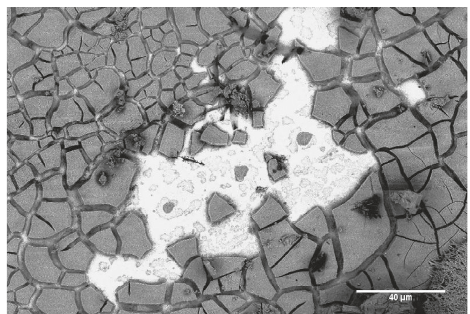
Figure 8: SEM image of a crack region on the surface of the sample synthesized at 120 ° C for 36h with NaOH concentration of 0.75M after heat treatment. Table 3: Analysis of variance (ANOVA) of the 2 3 full factorial design.